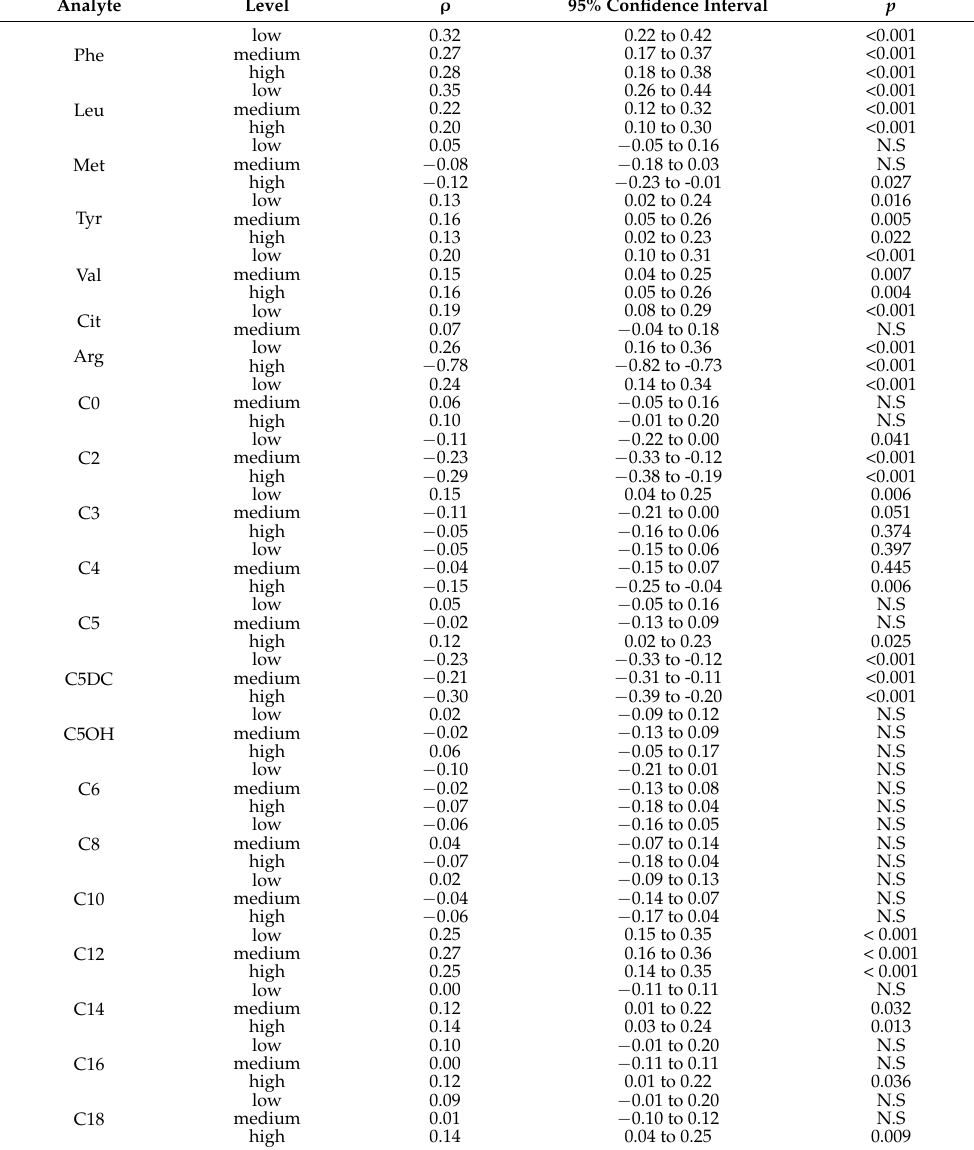
Table 3. The results of correlation analysis between time and measured values of each analyte. Analyte